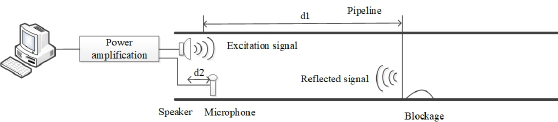
Fig. 2. Schematic diagram of blockage detection